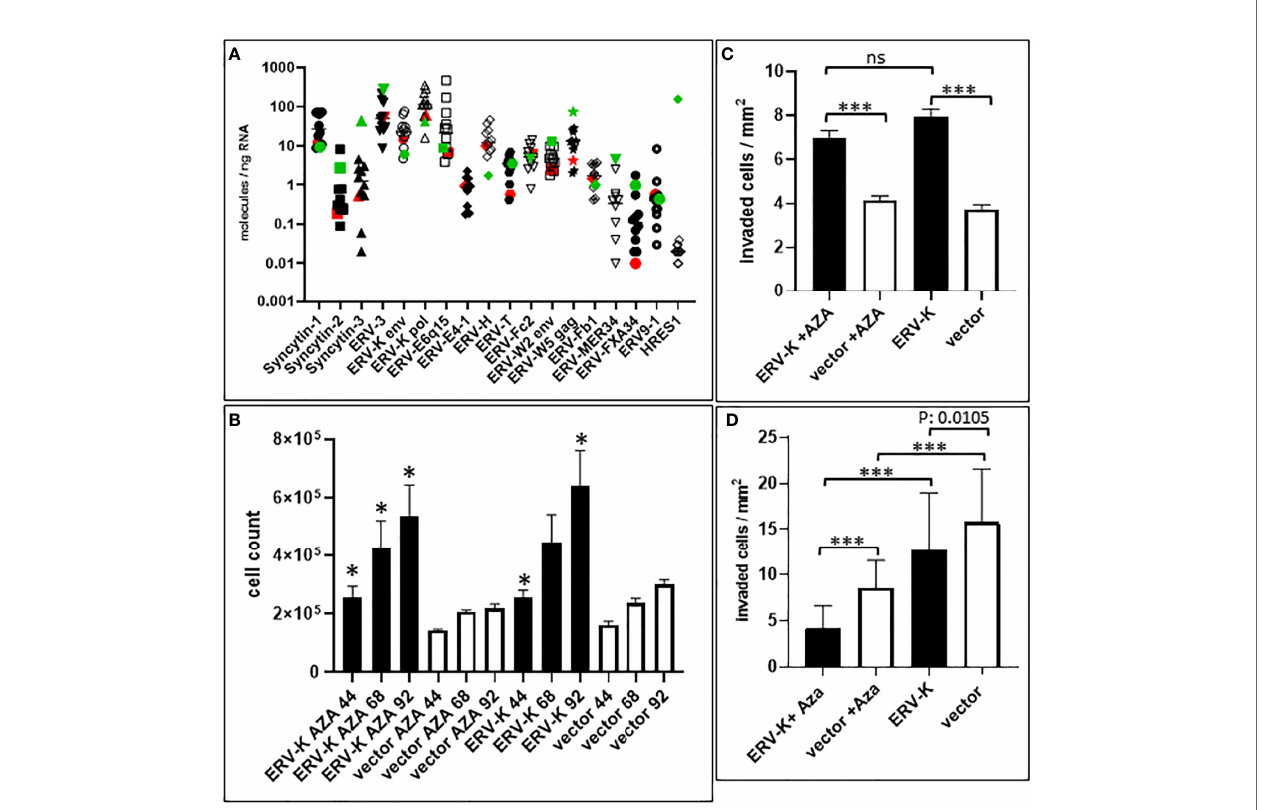
FIGURE 5 | ERV gene expression in ccRCC cell lines and functional studies. (A) Graph shows gene expression (molecules/ng RNA, Y-axis) pro fi ling 16 different ERV gene families (X-axis) of 12 different cell lines (ccRCC = 11 see Materials and Methods ; Red= MZ1257RC ccRCC cell line; Green = HEK293). Note that ERV-Fc1 env and ERV-Rb env are not shown on the graph since they were undetectable for gene expression. (B) Graph shows MZ1257RC cell proliferation (Y-axis = total cell counts) following transient transfection with the overexpressing CMV vector containing a codon optimized ERV-K113 env gene at 44 h, 68 h and 92 h post transfection in the presence or absence of Aza. (n= 4); *p = 0.0286. (C) Graph shows MZ1257RC 3D cell invasion into collagen (Y-axis = # of invaded cells/mm 2 ) following transient transfection with the overexpressing CMV vector containing a codon optimized ERV-K113 env gene at 68 h post transfection in the presence or absence of Aza. (n= 6), ***p < 0.0001; ns = non-signi fi cant. (D) Graph shows HEK293 3D invasion into collagen (Y-axis = # of invaded cells/mm 2 ) following transient transfection with the overexpressing CMV vector containing a codon optimized ERV-K113 env gene at 68 h post transfection in the presence or absence of Aza. (n= 3), ***p <